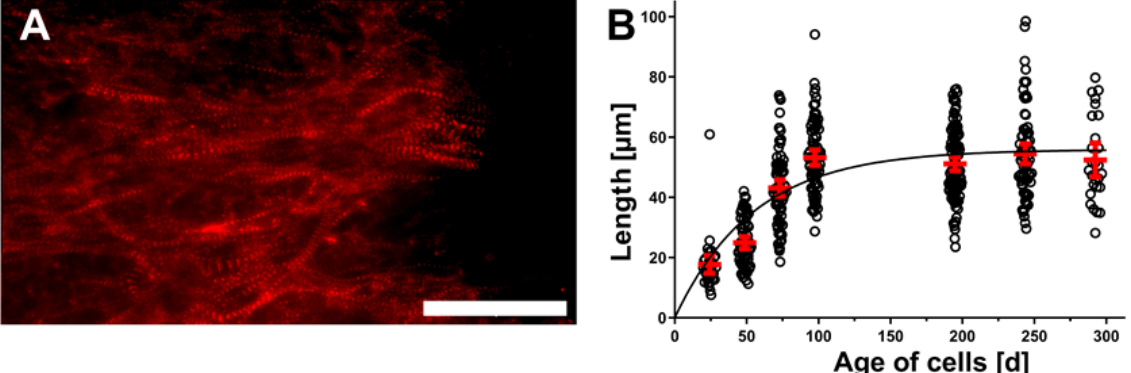
Figure 1. hPSC derived CM mature within the self-organizing 3D network by extended cultivation time. ( A ) Typical striated pattern of immunohistochemically stained α -actinin (ACTN) after 75 days of cultivation. Scale bar: 50 µ m. ( B ) Measurements of α -actinin chain lengths in µ m over a cultivation period of 300 days after differentiation initiation. Circles show multiple individual measurements (n = 27–106) of >3 hPSC-CMC per time point. Line indicates nonlinear fit of data. Red marks represent the means ± 95%